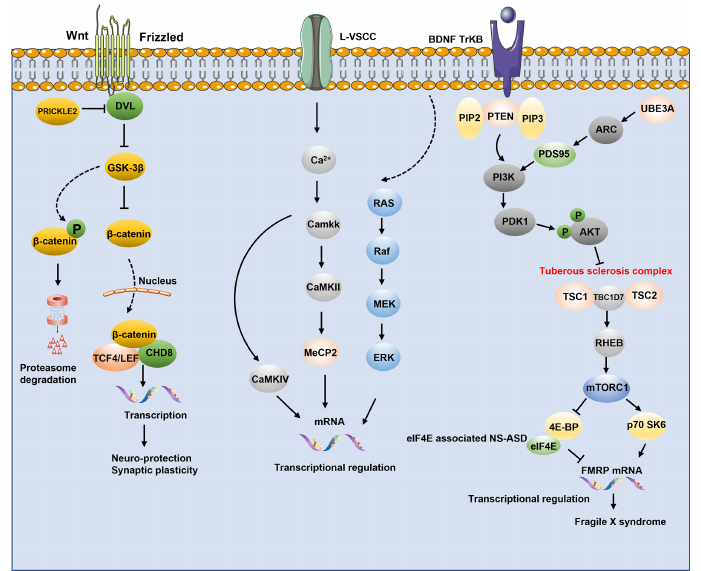
Figure 2. The Synaptic signaling pathway are mechanistically targeted. Wnt pathway activation of cytoplasmic β -catenin is degraded by the proteasome after phosphorylation by GSK-3 β . When GSK-3 β fails to phosphorylate β -catenin, cytoplasmic β -catenin accumulates in the nucleus and binds to the TCF/LEF complex and CHD8 factor to activate transcription of target genes and enhances synaptic plasticity and neuronal protection. Both ERK/MAPK and PI3K-AKT-mTOR signaling pathways can be activated in response to TrKB stimulation Activation of L-type voltage-sensitive calcium channels (LVSCCs) triggers calcium inward flow and induces calcium-dependent signaling molecules and the Ras/ERK pathway, which are involved in transcriptional regulation. Mutations in proteins involved in translational regulation include PTEN, MECP2, UBE3A and TSC1/TSC2. These genes are marked in red .